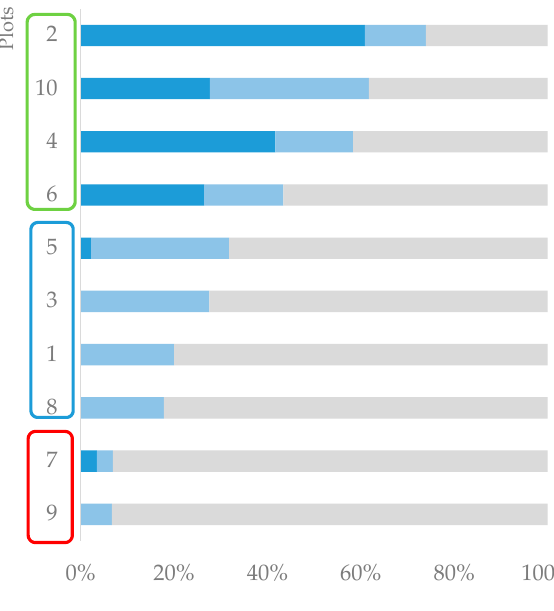
Figure 2. Total resprouting rate and proportion of resprouting type per plot. The different resprouting patterns identified resulted in three groups of plots: G1 (red), G2 (blue), and G3 (green).